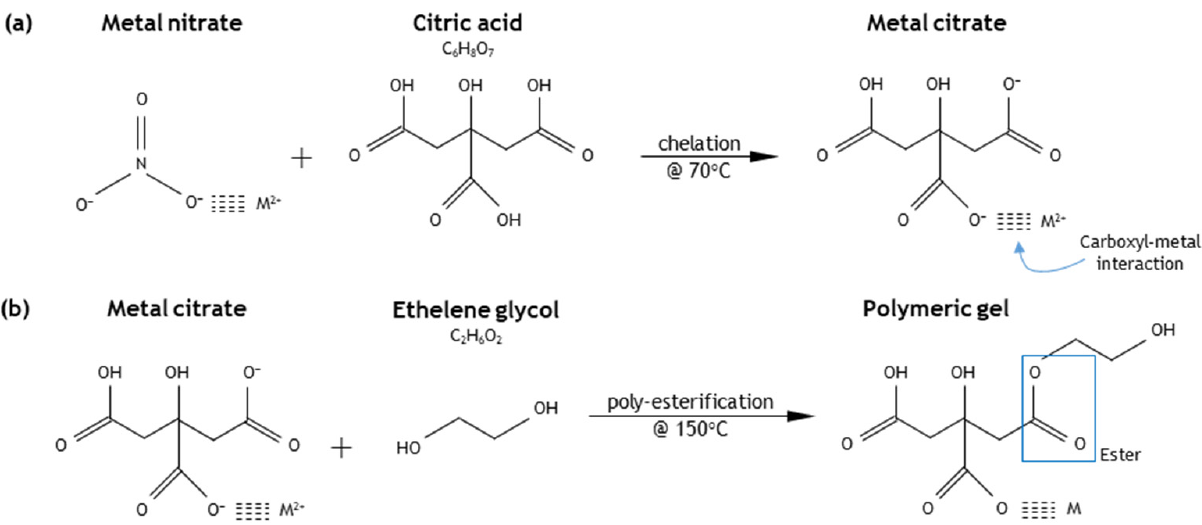
Figure 1. Schematic of the crosslinking reaction, which occurred during ( a ) chelation and ( b ) poly- esterification.